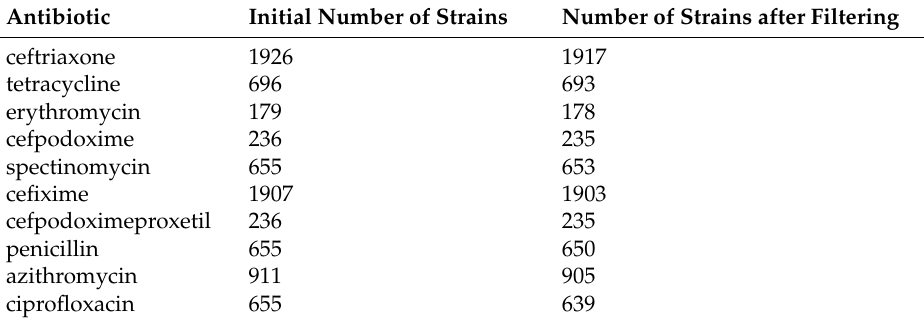
Table A2. N. gonorrhoeae . Number of genomes for each antibiotic.